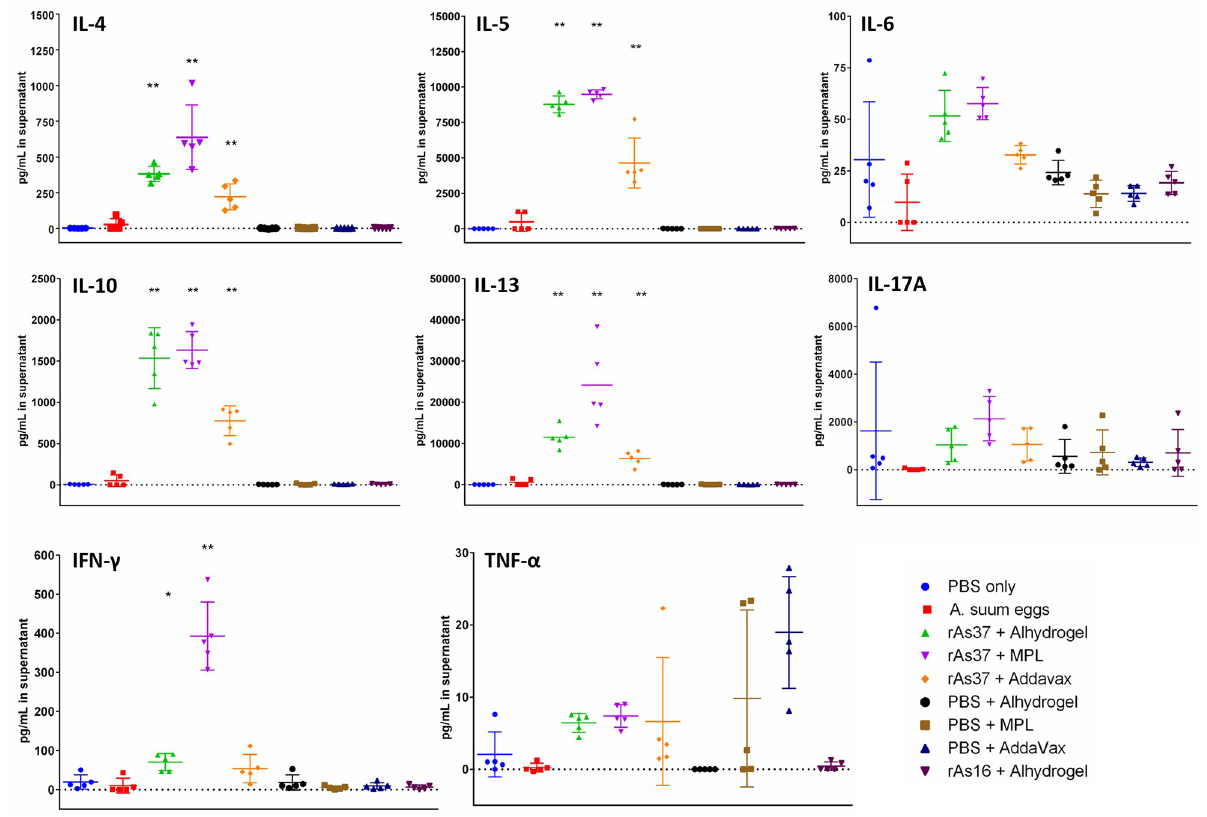
Fig 5. Cytokine profiles of BALB/c mice immunized with rAs37 formulated with Alhydrogel, MPL, and AddaVax. Cytokine levels were determined in supernatants of splenocytes after being re-stimulated with rAs37 (25 μ g/ml) for 48 hours. Cytokine values measured in unstimulated samples were subtracted from the cytokine values from the corresponding rAs37 re-stimulated samples. Data are presented as means and individual values for each group (n = 5). � p < 0.05, �� p < 0.01.